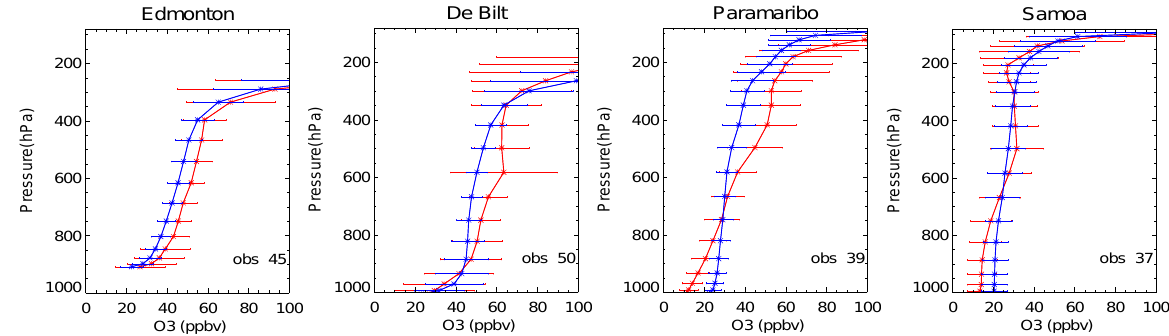
Fig. 16. The annual average modeled ozone profiles (blue) compared to WOUDC sonde observations (red) for the stations shown in Fig. 15.